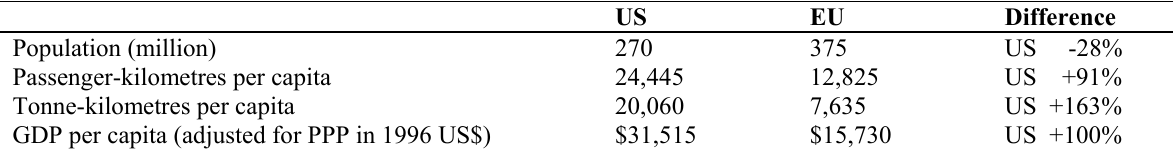
US -28% US +91% US +163% US